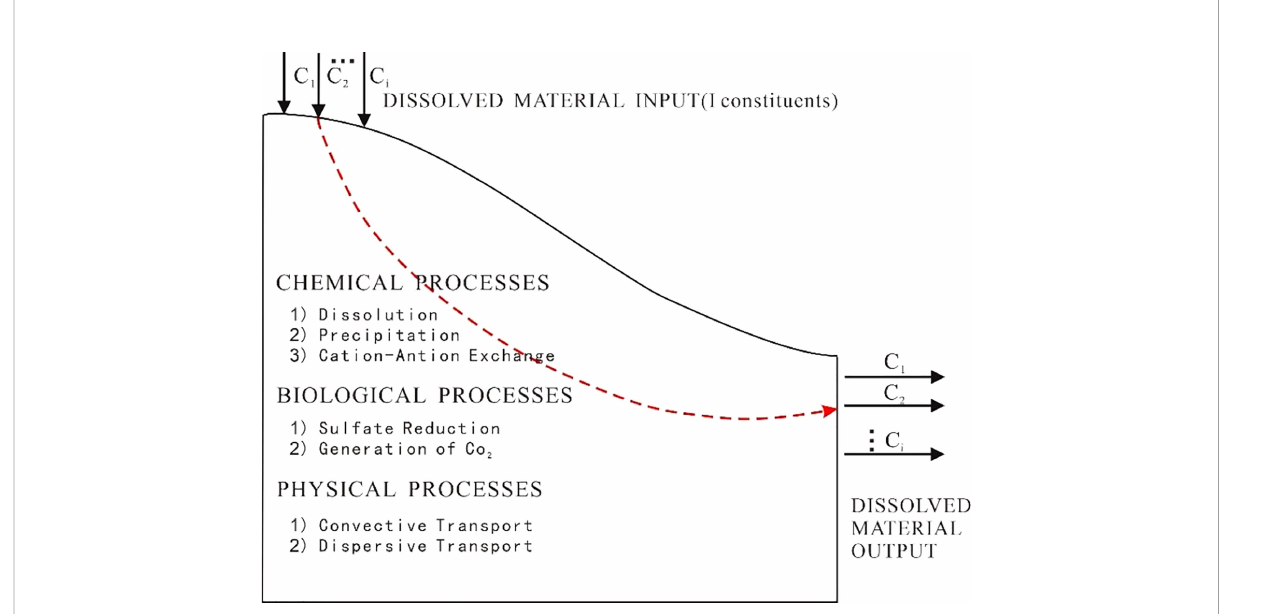
FIGURE 3 Conceptualization of mass transfer in regional groundwater fl ow (from Schwartz